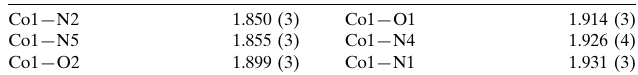
Selected bond lengths (A˚ ).